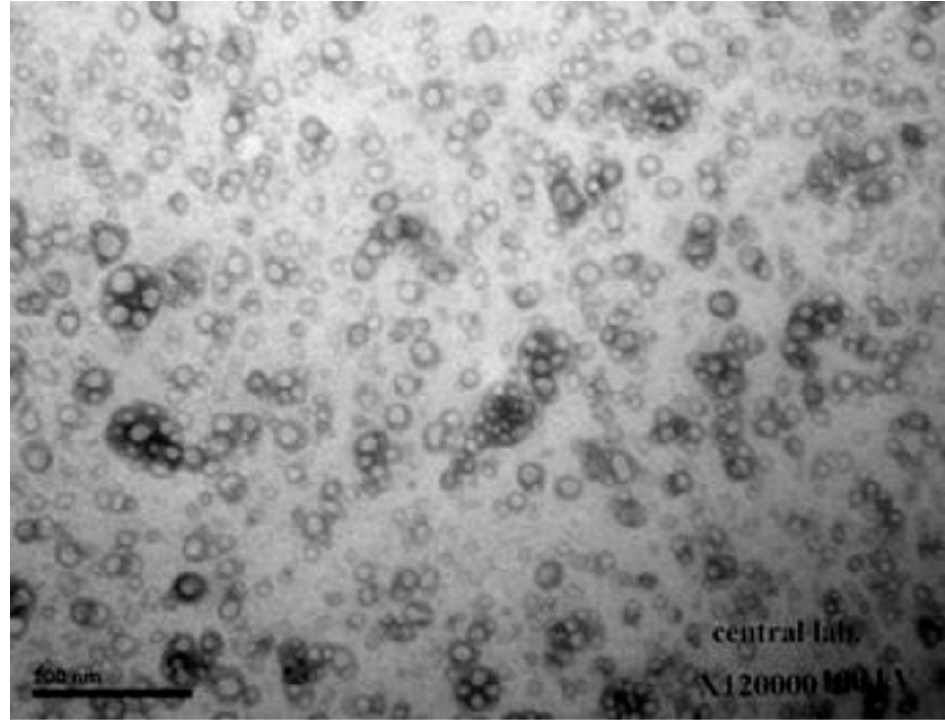
Figure 1. TEM image of ciprofloxacin hydrocholride (CHCl)-loaded chitosan (CS) nanoparticles (NPs).